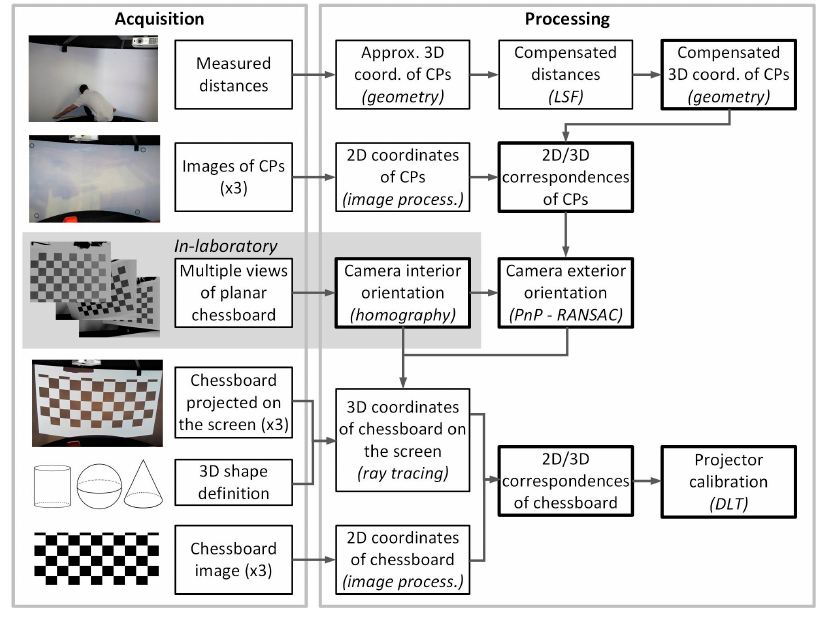
Figure 2. Data flow of the calibration procedure.